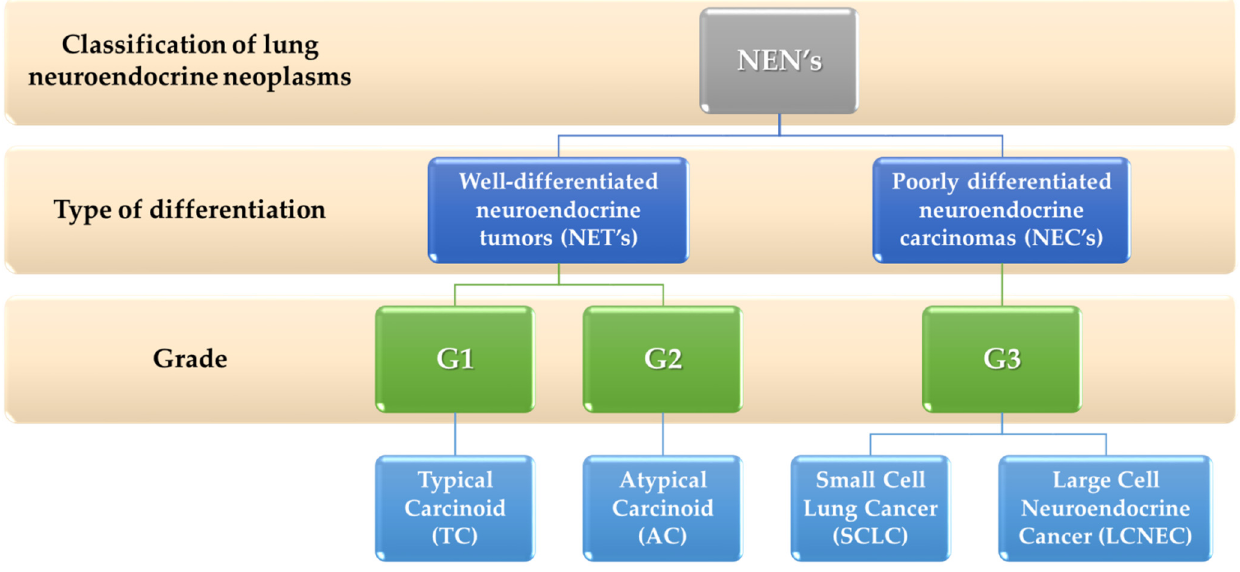
Figure 2. Division of lung neuroendocrine tumors based on [42].